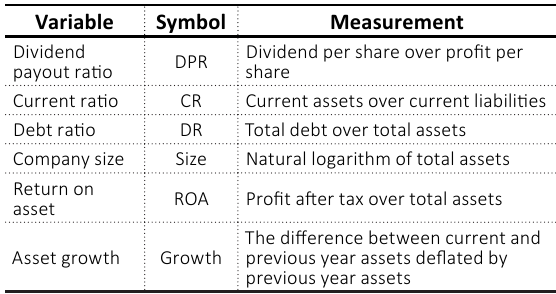
Table 3. Identification and measurement